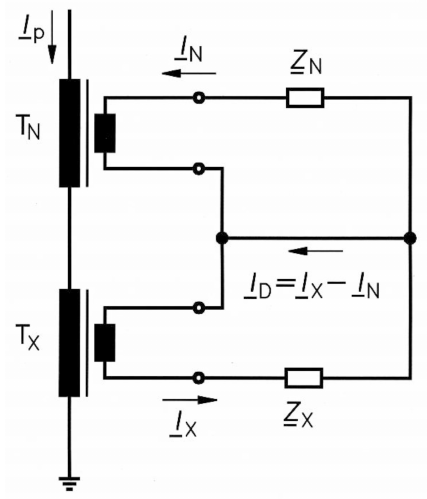
Figure 3. Principle of a measuring bridge for current transformers according to the difference method.